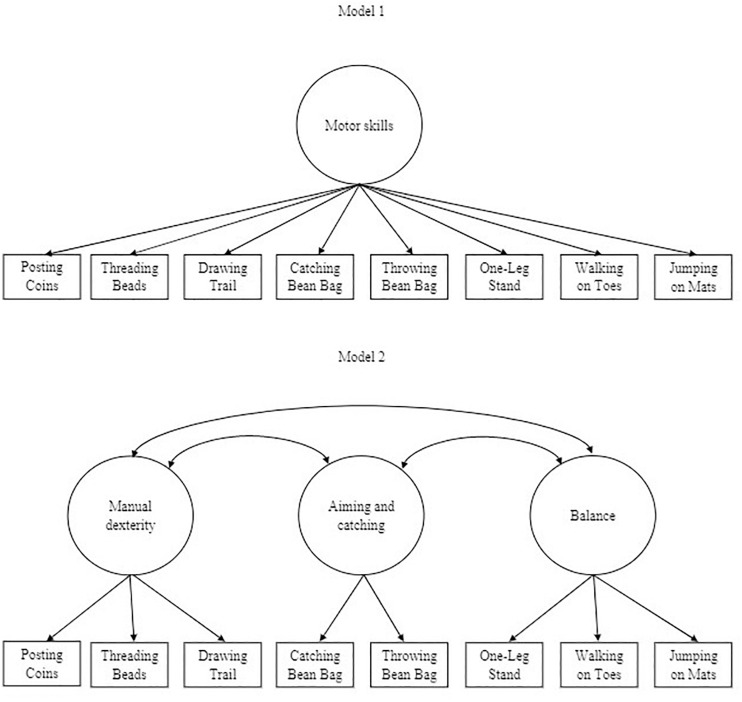
One-factor model of motor skills. Model 1 illustrates latent motor skills as a one-factor structure. Model 2 depicts latent motor skills as a three-factor structure, based on the structure of the Movement Assessment Battery for Children Second Edition (Henderson et al., 2007).